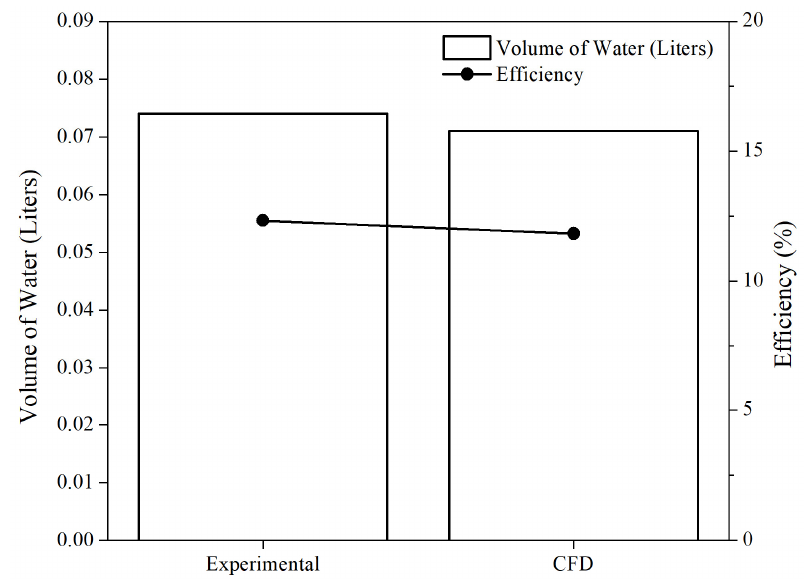
Figure 9. Comparison of the numerical and experimental model.